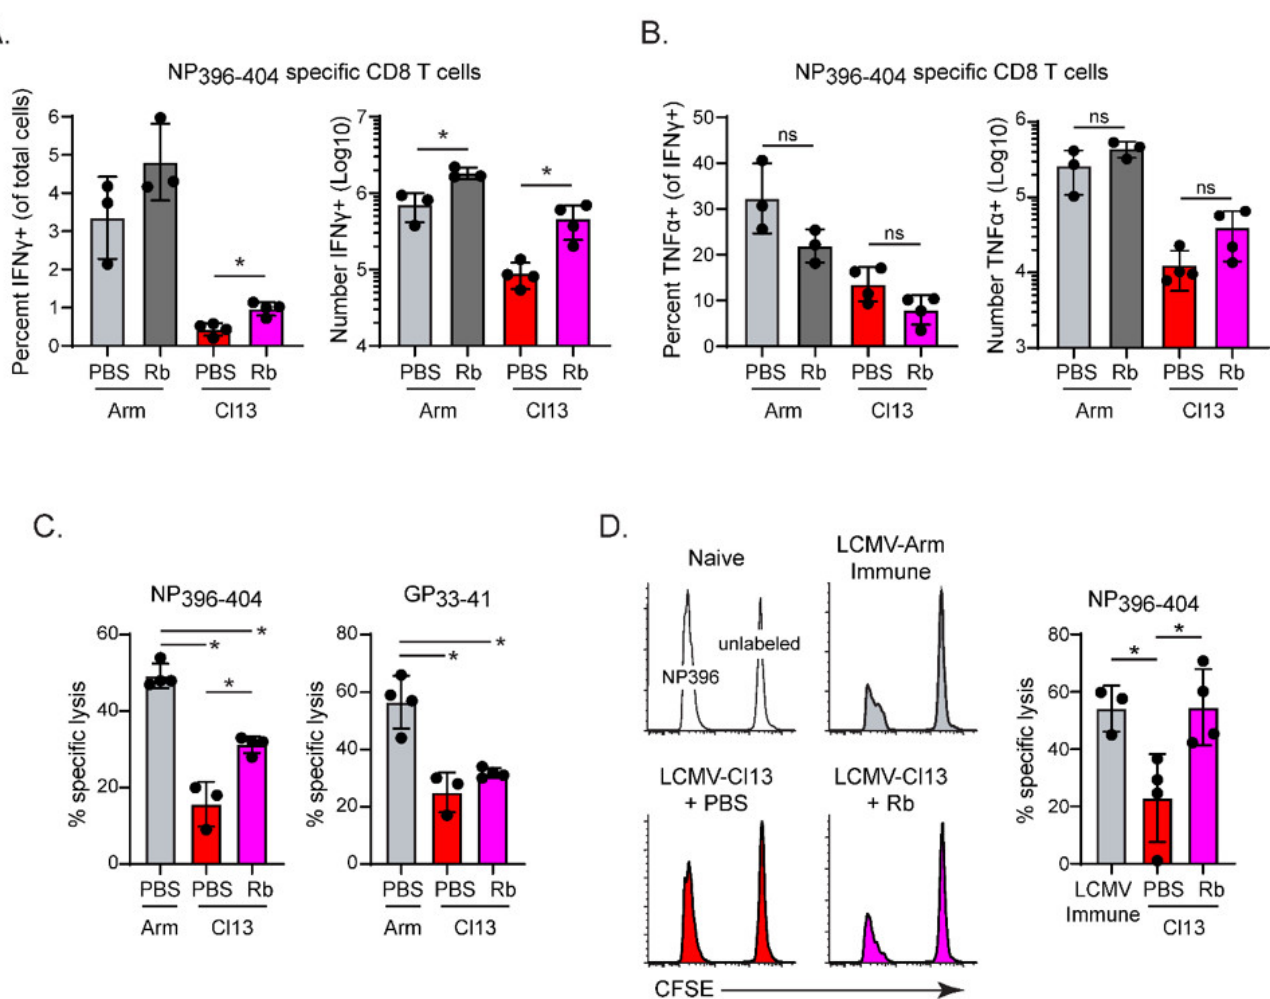
Figure 2. Early prevention and long-term functional rescue of high-affinity CD8 T cells. ( A , B ). Splenocytes from PBS-treated or Rb-treated LCMV-Arm or LCMV-Cl13 infected C57BL/6 mice were analyzed on day 9 after infection. Graphs illustrate ( A ) the frequency and number of IFNγ-producing, and ( B ) of TNFα and IFNγ double producing NP 396–404 -specific CD8 T cells following ex vivo peptide restimulation. The bars represent the average ± SD of 4 mice (individual circels) in each group and represent multiple experiments. *, p < 0.05. ( C ) In vitro 51 Cr release activity against target cells coated with LCMV-NP 396–404 peptide or LCMV-GP 33–41 peptide (effector:target ratio of 50:1) on day 9 post infection. ( D ) In vivo CTL assay (day 50 after infection). Peptide-unlabeled or NP 396–404 peptide-labeled target cells (splenocytes) were co-transferred into LCMV-naïve mice, LCMV-Arm immune mice (day 50 after infection) or LCMV-Cl13 infected mice (day 50 after infection) that were either PBS-treated or had been treated with Rb on days 1 to 8 after infection. Histograms show a single mouse with each condition, and the bar graph indicates the percent NP 396–404 -specific lysis. The bar graph shows the average ± SD of 3 (Arm infection) or 4 (Cl 13 and Cl 13 + Rb infections) mice per group. The circles on each bar represent individual mice. * p < 0.05; student’s t-test (unpaired, two-tailed).